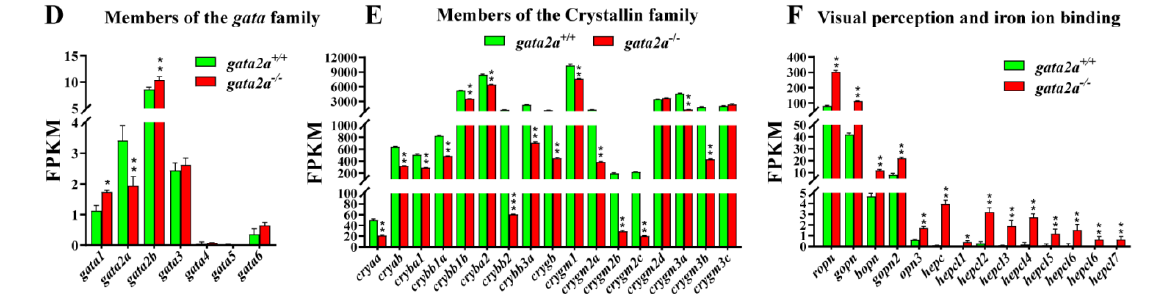
Figure 5. Comparative transcriptomic analysis of genes and molecular pathways dysregulated in gata2a −/− eyes. ( A ) Heatmap displaying difference in gene expression between eyes from WT ( gata2a +/+ ) and gata2a mutants ( gata2a −/− ) at 35 dpf. ( B ) Volcanic map of differentially expressed genes (DEGs) between the eyes from WT and gata2a mutants. A total of 1982 and 1633 genes were down- regulated and upregulated, respectively, in the eyes from gata2a mutants compared with the eyes from WT fish. ( C ) Scatter plot of the enriched KEGG pathways for the DEGs. The sizes and colors of the dots represent the number of genes and the significance of the difference, respectively. ( D ) Effects of gata2a mutation on gene expression of the gata family. ( E , F ) Gata2a mutation down-regu- lated crystallin family genes ( E ), and up-regulated visual perception and iron ion binding-related genes ( F ) in the eyes. Data were presented as the mean ± SD of triplicates. Differences between groups were statistically examined with two- tailed unpaired Student’s t -test. Significant difference is denoted by * ( p < 0.01) and ** ( p < 0.001).